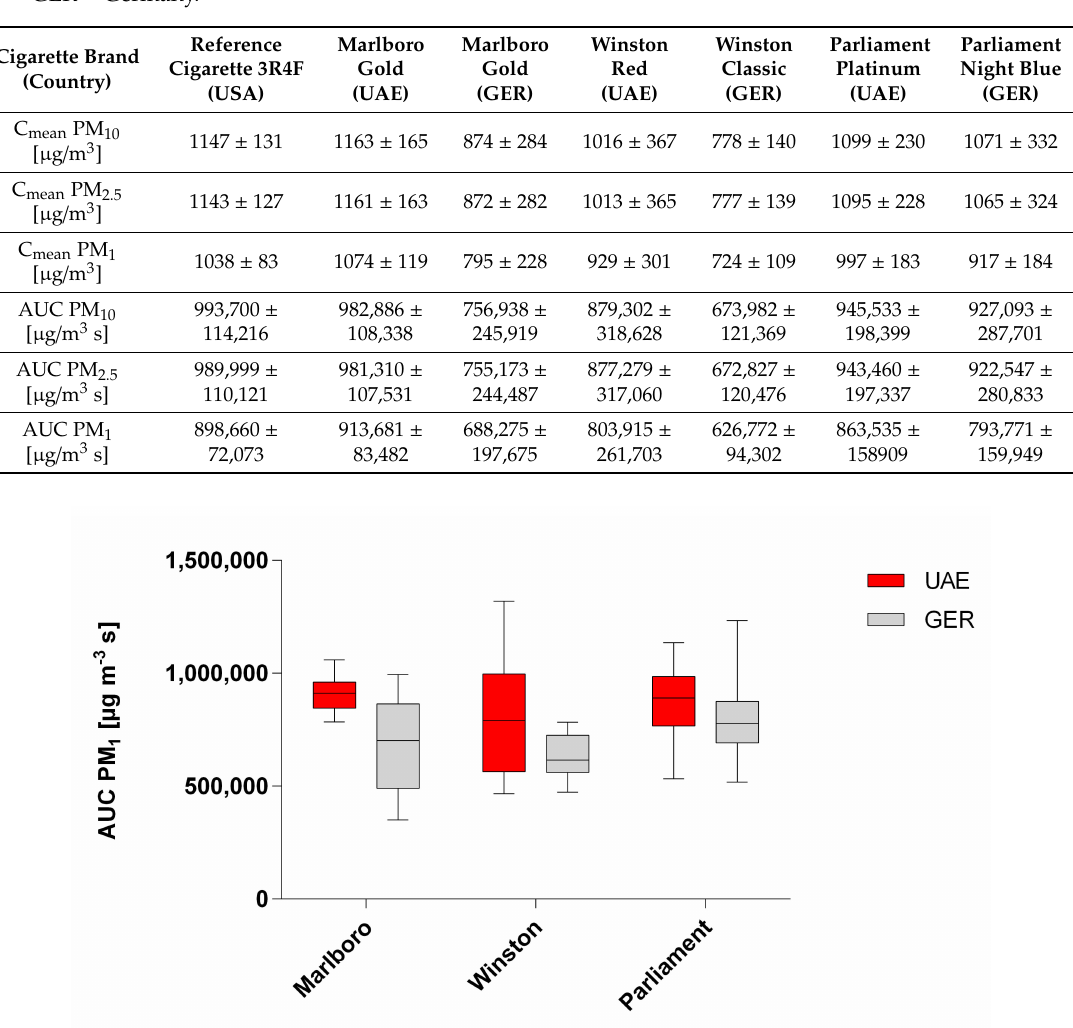
Table 2. Mean concentrations (C mean PM 10 , PM 2.5 and PM 1 ) and Area Under the Curve (AUC PM 10 , PM 2.5 and PM 1 ) with standard deviation of all tested tobacco products. UAE = United Arab Emirates. GER = Germany.